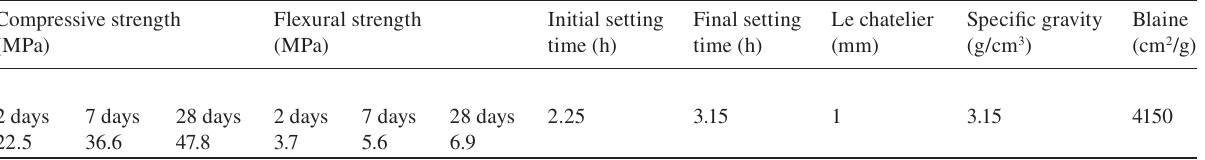
Table 3 Physical and mechanical properties of Portland